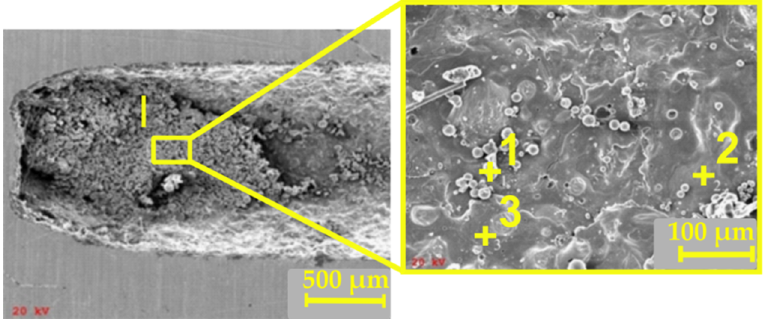
Figure 14. Scanning electron microscopy (SEM) images of the internal surface of the hole subjected to a qualitative analysis in Zone I. Machining parameters: U = 80 V, t i = 818 μs, I = 4.32 A.